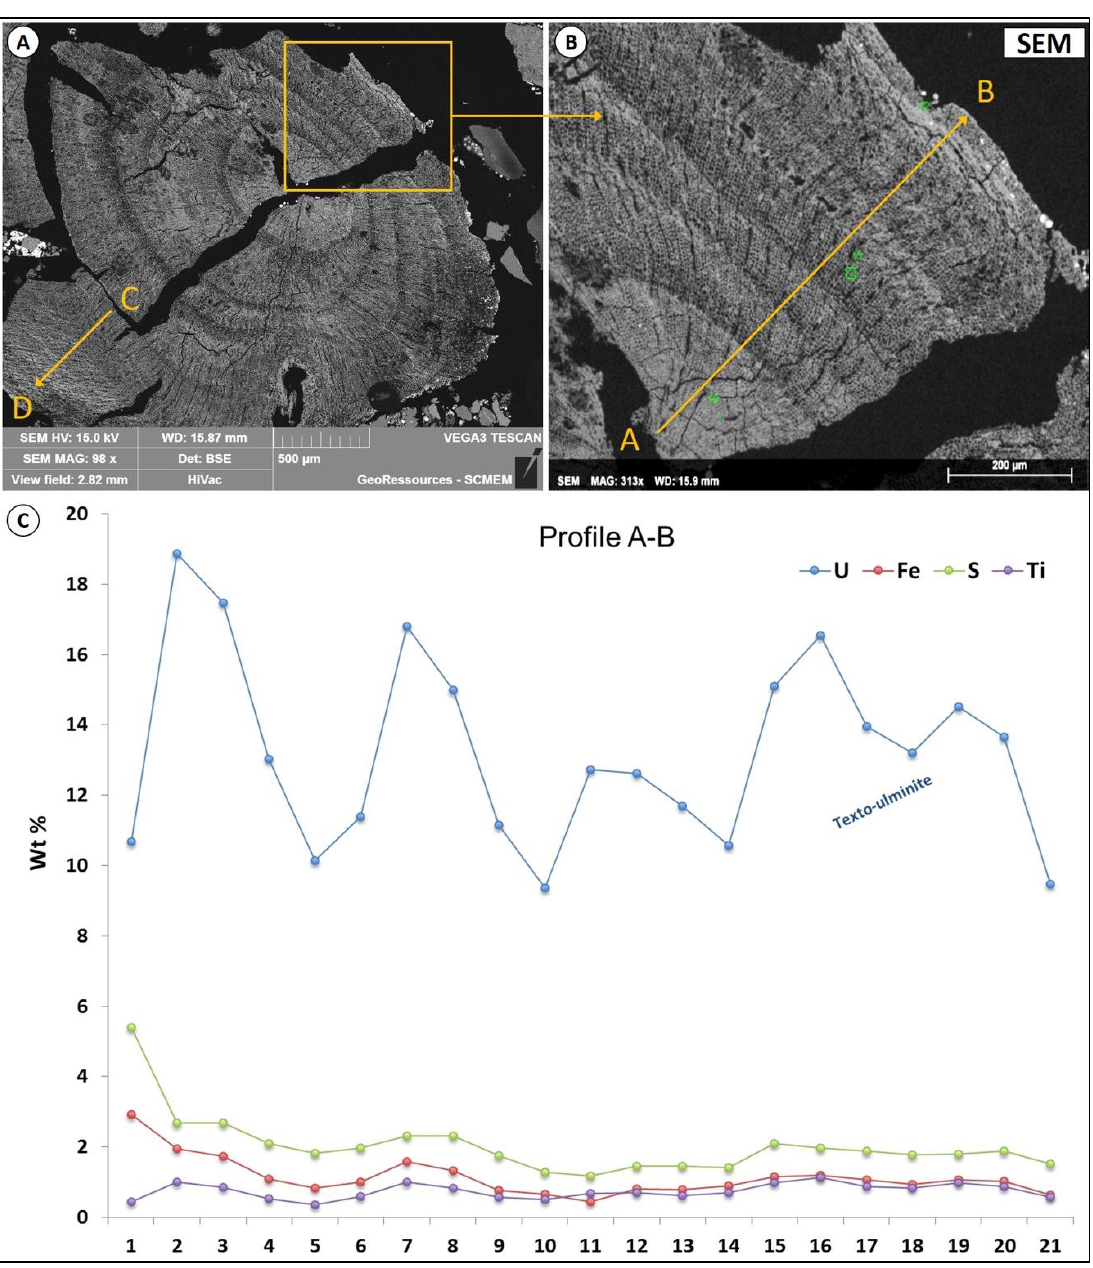
Figure 8. (A ) View of a well-preserved root structure (telohuminite) typical of the organic matter contained in the Zoovch Ovoo sediments and the associated X-Ray microfluorescence maps. ( B ) Zoomed image of a part of the root highlighting the EPMA profile (A-B) for U, Fe, S, Si and Ti, respectively. ( C ) According to the EPMA profile of A-B performed on the root structure (texto-ulminite), S and Fe are always present inside the particle; however, their stoichiometry does not indicate pyrite. Titanium is also present in minute quantities ( < 1 wt %). Uranium concentration fluctuates between 10 and 19 wt %. Sulfur and Fe concentrations along profiles A-B and C-D are projected on a binary plot (Figure 9). The Fe-S data points for the internal part (A-B) of the root are very close to pyrite stoichiometry. The profile (C-D) of the external part shows a trend enriched in Fe from 1 to 8 wt %, while S fluctuates between 0.5 and 2.8 wt %. Data points from both profiles indicate an enrichment in S up to 1 wt % compared to pyrite stoichiometry, while Fe enrichment may exceed mackinawite stoichiometry in profile